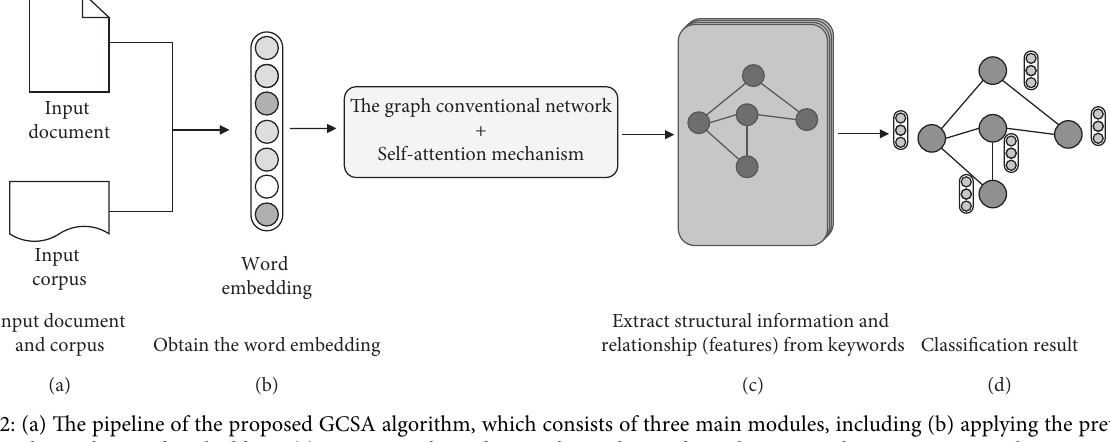
Figure 2: (a) The pipeline of the proposed GCSA algorithm, which consists of three main modules, including (b) applying the pretrained model to obtain the word embedding, (c) extracting dependency relationship and employing graph-attention network to estimate the similarity between candidate words and corpus, and (d) performing the subsequent classification.